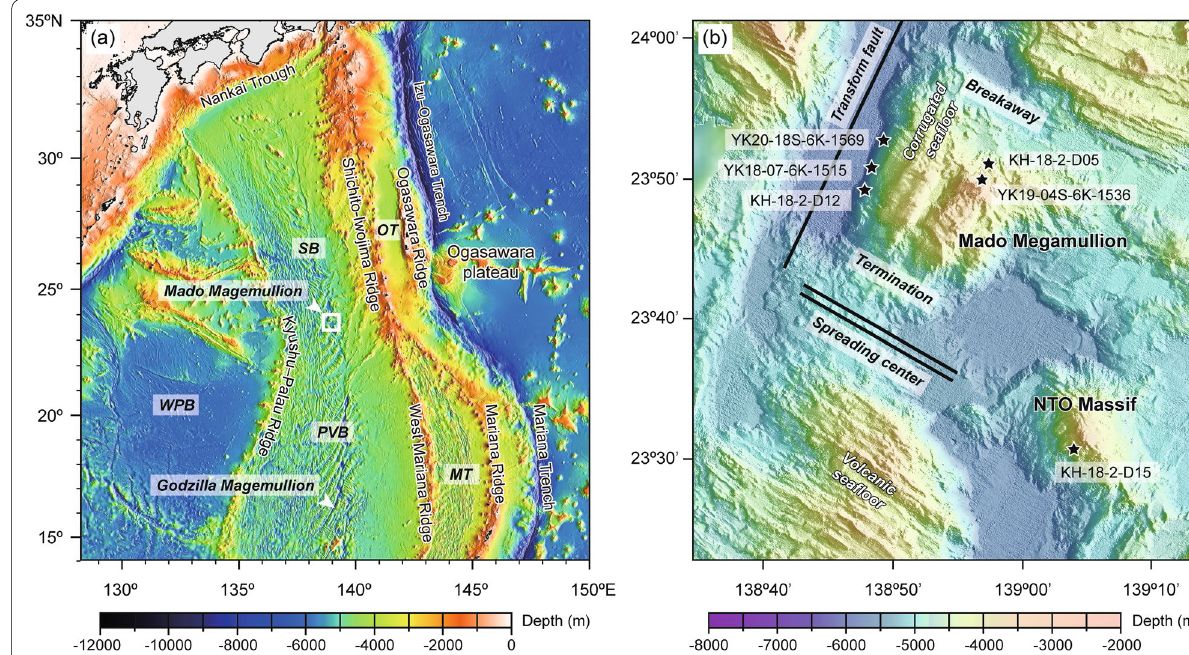
Fig. 1 Bathymetric maps including the location of Mado Megamullion. The white square in a corresponds to the area shown in b . The black stars in b indicate the sampling sites. Abbreviations: MT SB Shikoku Basin, and WPB =